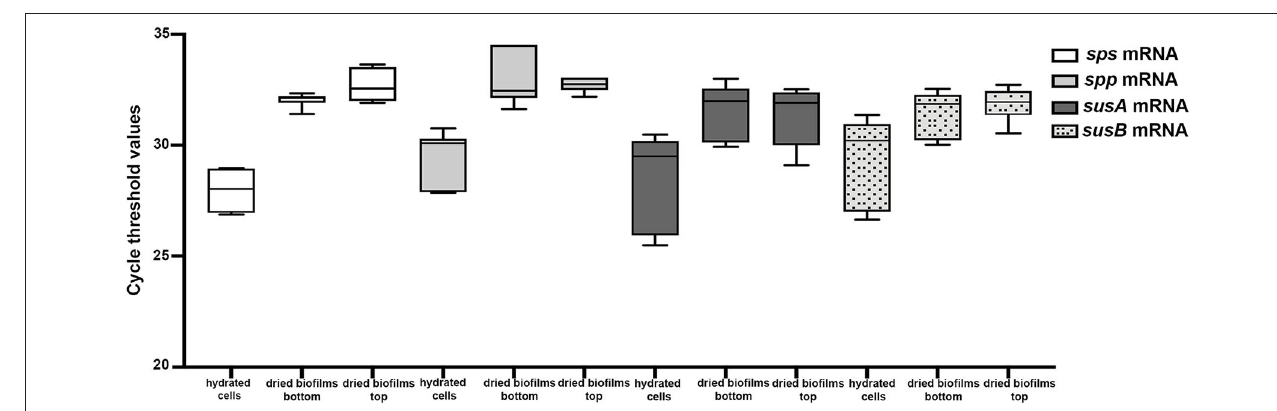
FIGURE 3 | Permanence of mRNA in 7-year dried Chroococcidiopsis biofilms mixed with P-MRS, according to Ct values in the RT-qPCR assay. Control: hydrated cells under laboratory routine growth conditions; bottom: dried biofilms exposed to Mars-like atmosphere; top: dried biofilms exposed to Mars-like UV flux (5.7 × 10 5 kJ/m 2 ) and Mars-like